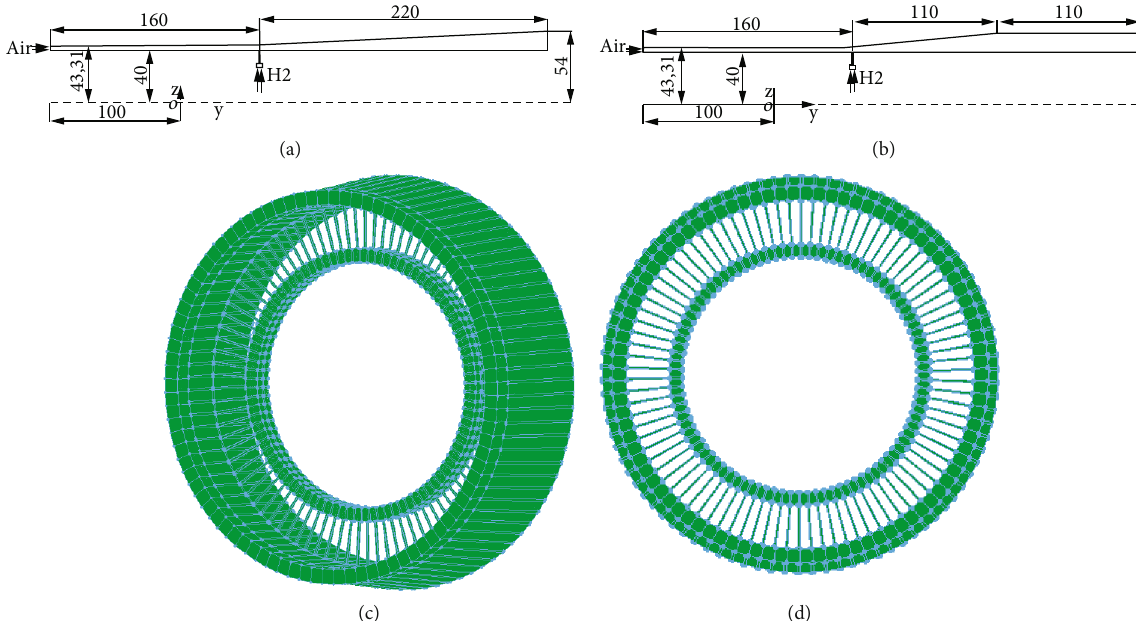
Figure 1: Schematic view of the computing domains: (a) case 1; (b) case 2 (unit: mm); (c) local 3D view of case 1; (d) streamwise 3D view of case